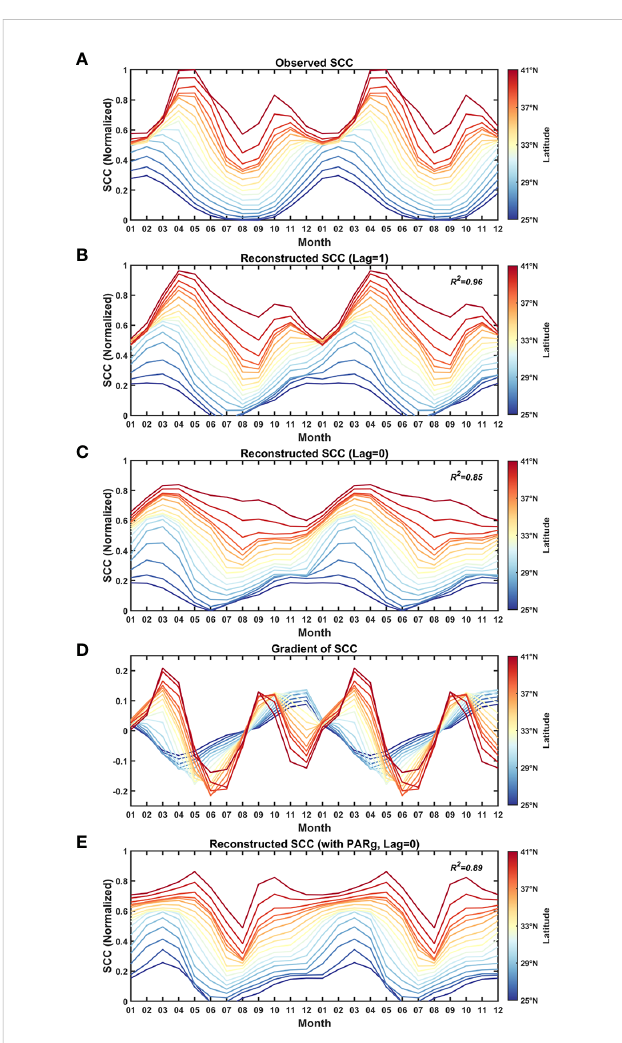
FIGURE 6 Seasonal cycle of (A) Observed SCC, (B) Reconstructed SCC using PAR and N with PAR one month ahead of SCC, (C) Reconstructed SCC with concurrent PAR, (D) Gradient of observed SCC and (E) Reconstructed SCC with concurrent PARg, at different latitudes. The seasonal cycles of SCC are generated by averaging the data from 2003 to 2018 between